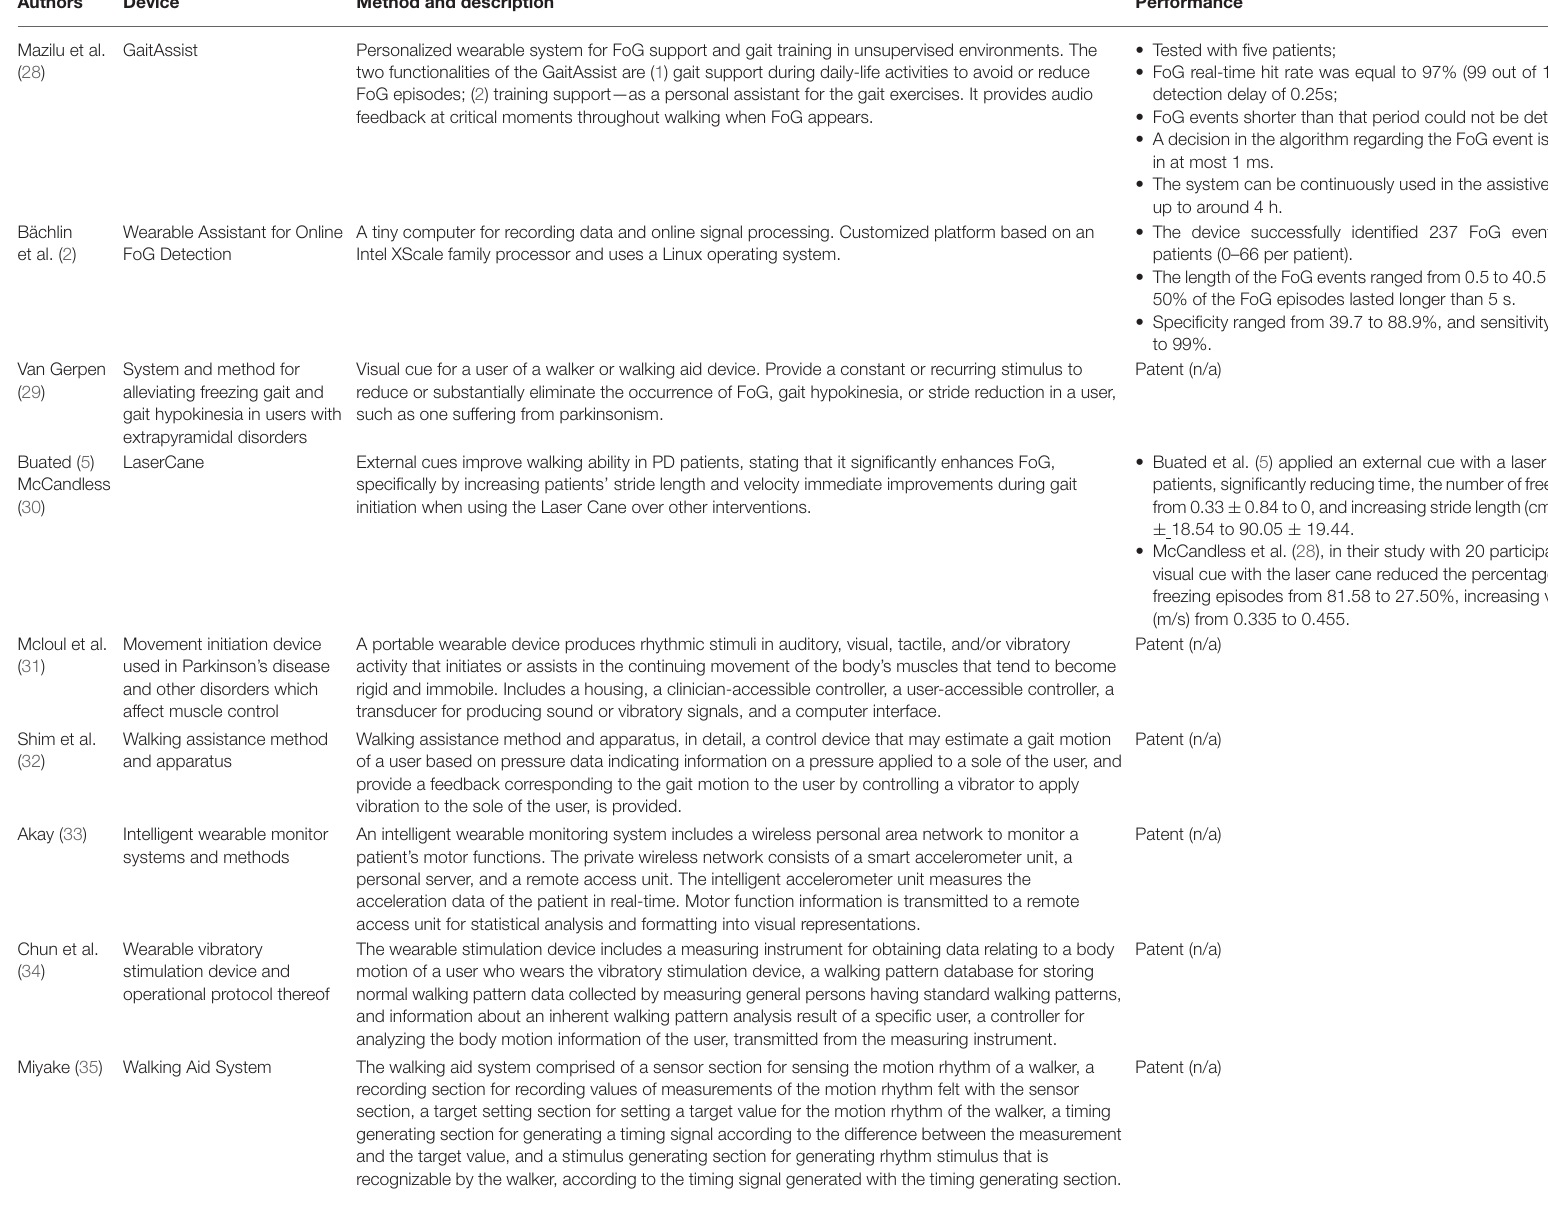
TABLE 2 | Current cueing devices and registered patents for FoG treatment. Authors Device Mazilu et al. (